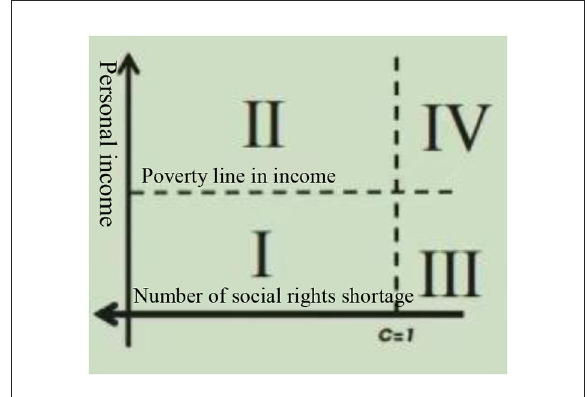
FIGURE1 Classification of population under multi-dimensional indicators approach. Source: Consejo Nacional de Evaluación de la Política de Desarrollo Social (7), Page 37. method, people with a lack of rights of 3 or more are classified in the extremely multidimensional poverty.